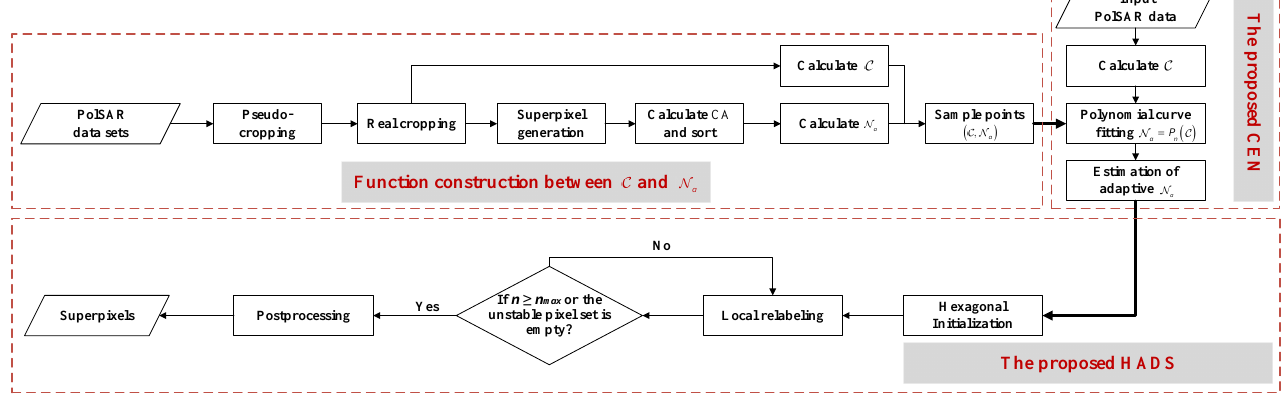
Figure 6. Flowchart of the proposed CEN and the proposed